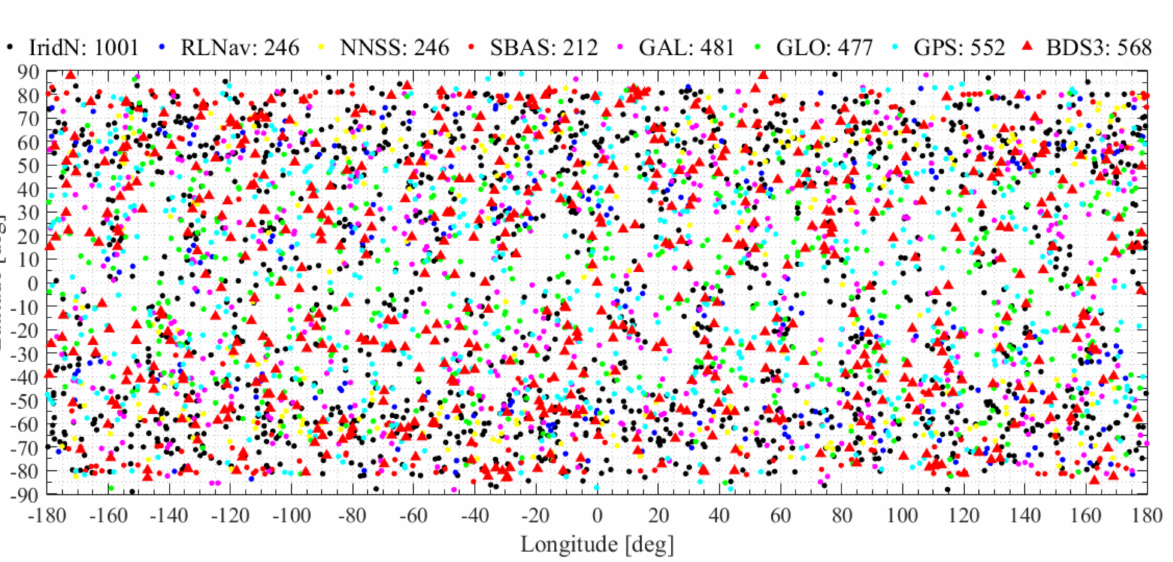
Figure 2. Distribution of the MET/multi − GNSS RO events on 21 June